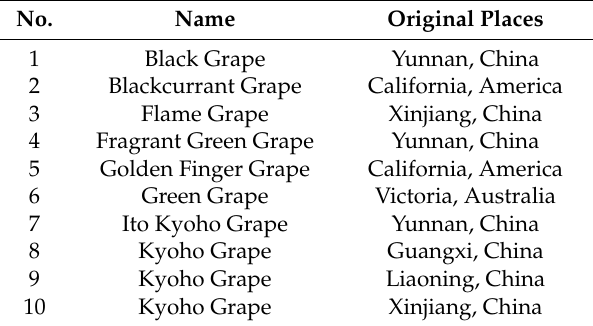
Table 3. Names and original places of the 30 grape varieties.